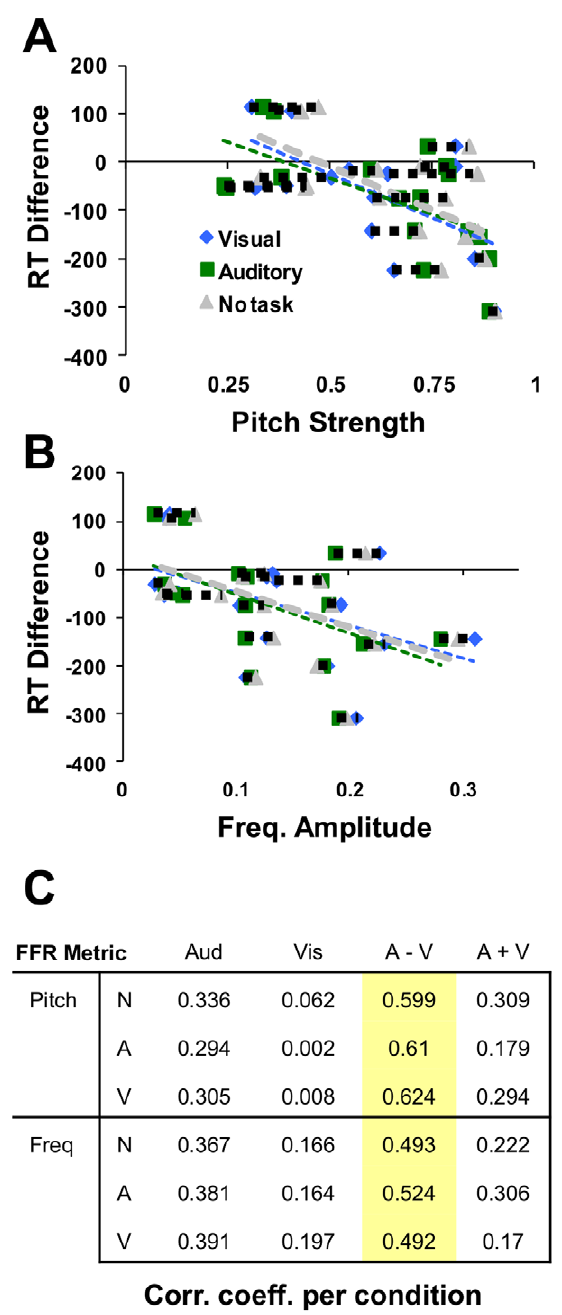
Figure 6. RT changes relative to each FFR metric. Subjects with higher pitch strength ( A ) and higher target frequency response amplitude ( B ) also showed the greatest response time difference (increasingly negative values) when comparing auditory and visual performance. Dashed lines connect each subject’s data for the three conditions. This relationship between RT and each FFR metric is consistent regardless of which task ( auditory , visual , or no-task , see table in Figure 6, C ) subjects were performing at the time (similarity of dotted line in Figure 6) Table lists correlation coefficients between response times (columns) and each of the two FFR metrics (rows), as observed within each of the three recording conditions (A=Auditory, V=Visual, N=No task). Highlighted values depict correlations significant at p , .05.